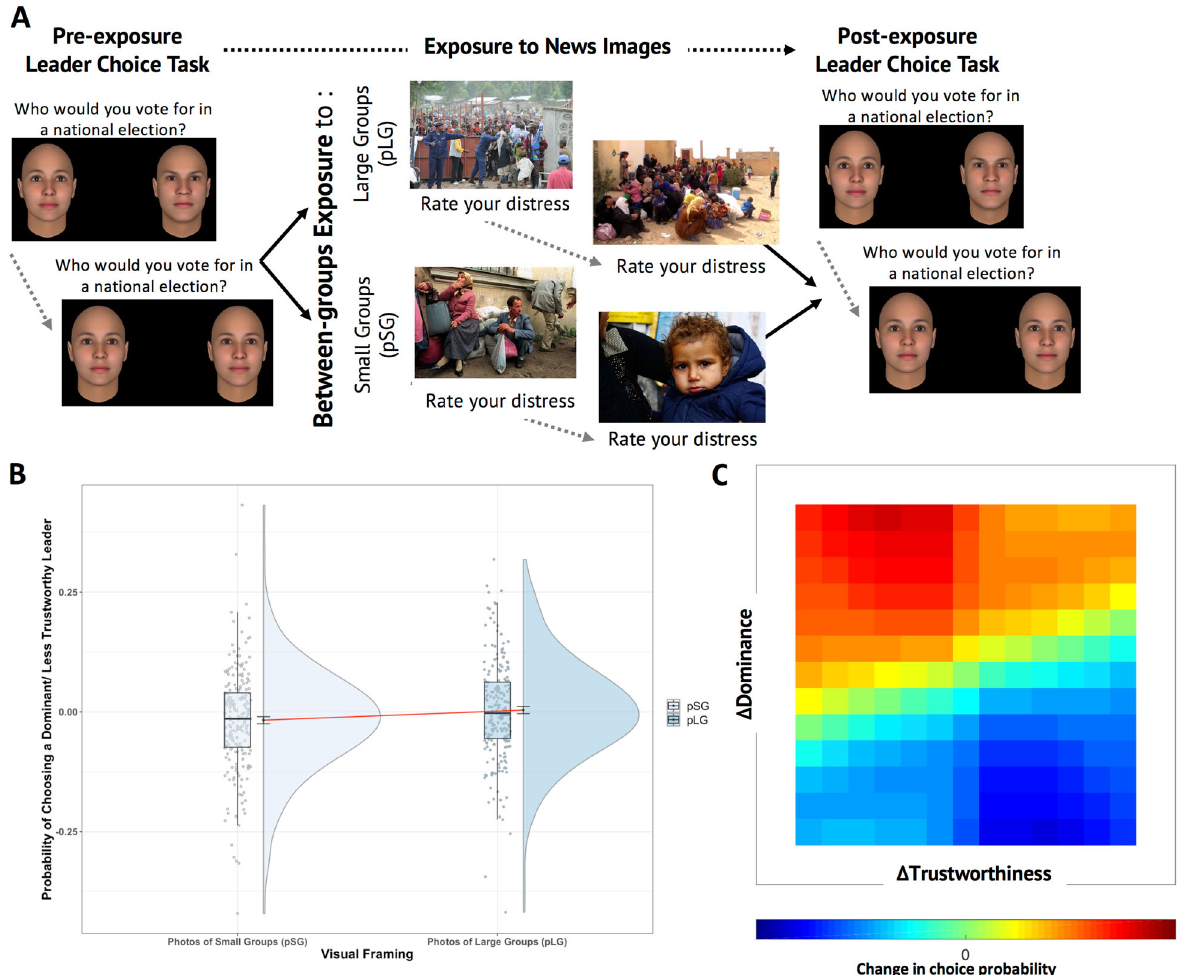
Fig. 4 Experimental design and results of study 7. A Between-subjects design of Study 7. Prior to exposure to pLG or pSG, participants completed a leader choice task. They had to choose which face out of a pair of avatar faces, scaled according to perceived Trustworthiness and Dominance, they would vote for in hypothetical upcoming national election. During the exposure phase, participants saw 25 images depicting refugees either in pLG or pSG and rated how distressful each image was on a VAS scale (0 — not distressing at all; 100 — highly distressing). After exposure, they completed again the task. Images depicted here are illustrative examples of visual framing (i.e. were not presented in any of our studies) Source: Wikimedia Commons, top left link , top right link , bottom left link , bottom right link . B Study 7: Raincloud plot with fi tted values of the main effects of Visual framing on the probability of choosing a dominant-looking and trustworthy-looking leader (Post- minus Pre-exposure). Y -axis = Probability of choosing a dominant and less trustworthy-looking leader, Post- minus Pre-Image exposure. Dots represent single data points, boxplots and half violin plots represent the mean and probability distribution according to condition. Red line, black points and error-bars (SEM) represent fi tted values of the main effect of Visual Framing on the probability of choosing a strong leader. After exposure to photos of large groups of refugees, participants signi fi cantly chose a more dominant and less trustworthy leader in comparison to the pSG condition ( p < 0.05). C Heatmaps for the probability of choosing a face as a leader according to perceived Trustworthiness ( X -axis) and Dominance ( Y -axis). Values are probabilities in percentage as a difference of Post – Pre image exposure as well as the difference of photos of Large Groups — photos of Small Groups. After exposure to pLG vs. pSG, participants were more likely to choose a face high in perceived Dominance (red pixels) and low in perceived Trustworthiness